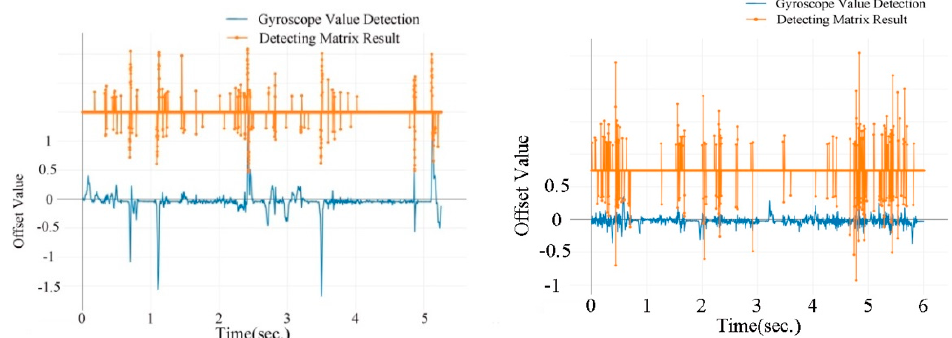
Figure 10. Detection with mobile parallel mounted ( a ) vs. catty-cornered mounted ( b ).